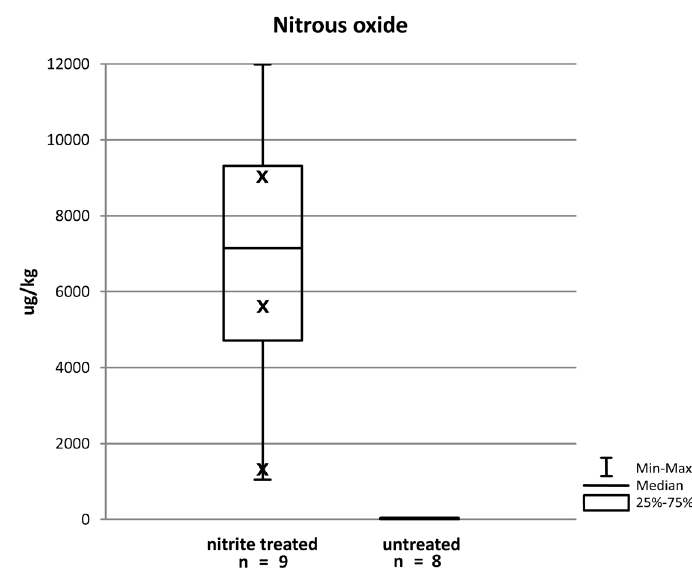
Figure 3. Box-and-Whisker-Plots of brining experiments. 15 N